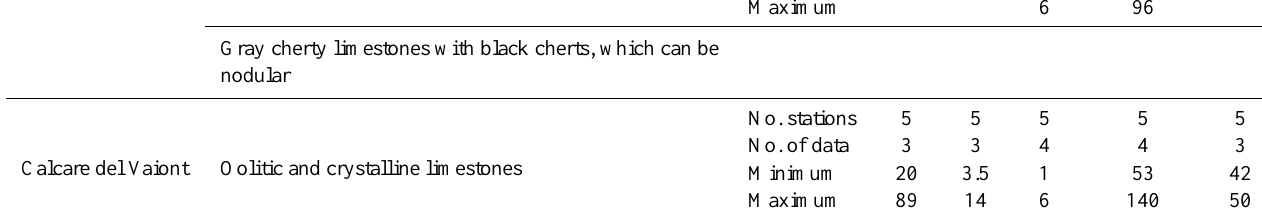
Red or nodular micrite, locally containing